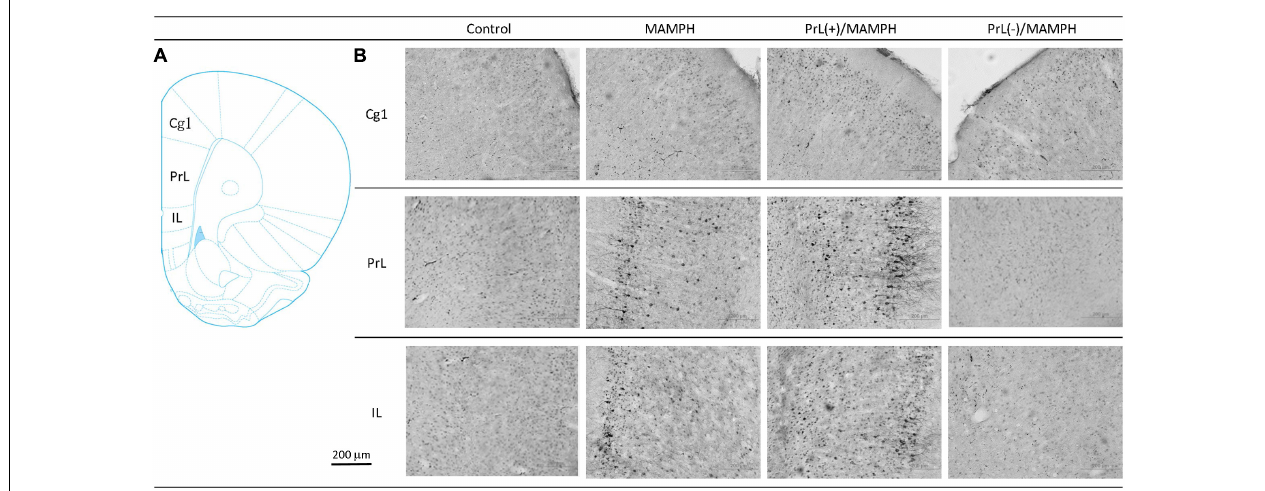
FIGURE 10 | (A) A schematic brain atlas for the Cg1, PrL, and IL of the mPFC. (B) Representative photomicrographs of p-ERK expression for the Cg1, PrL, and IL in the control, MAMPH, PrL(+)/MAMPH, and PrL(–)/MAMPH groups. The scale bar represents 200 µ m.